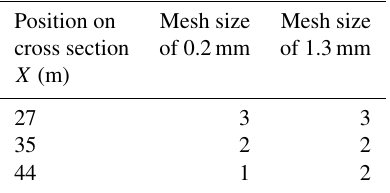
Table 3. Number of repetitions for each